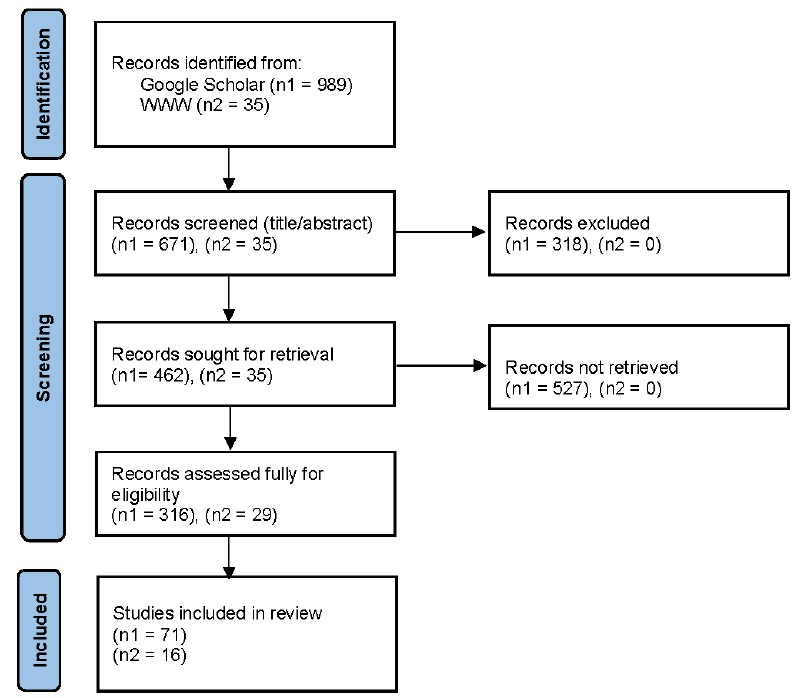
Figure 1. Summary of the Search Process.